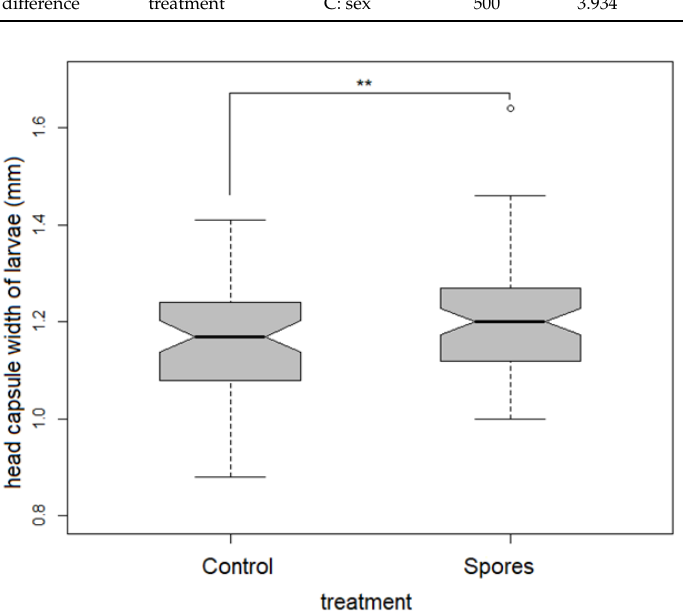
Figure 2. Significant differences in head capsule width in treatment groups within the larvae of both both sexes.